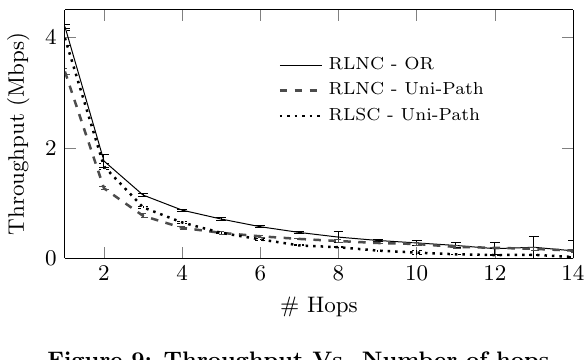
Figure 9: Throughput Vs. Number of hops